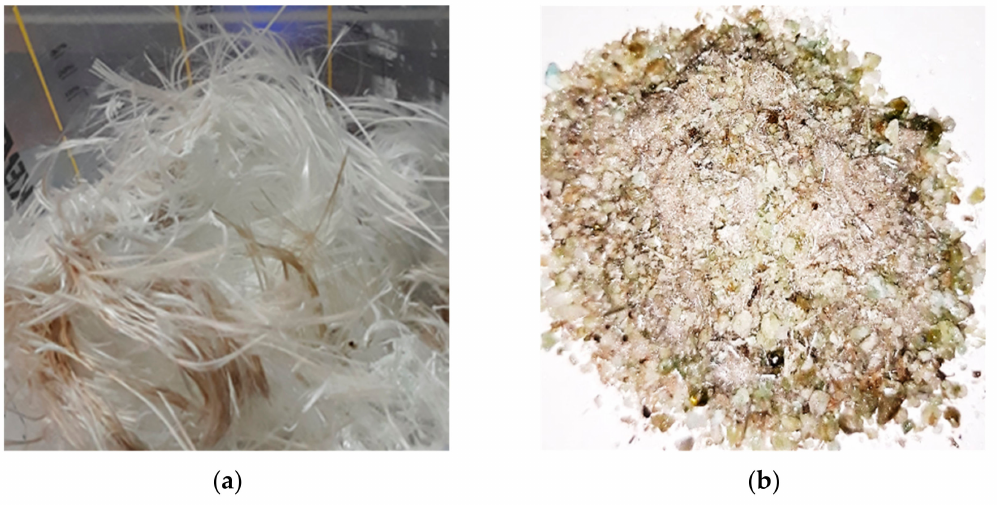
Figure 1. ( a ) Fiberglass waste; ( b ) fiberglass waste vitrified with hydrogen